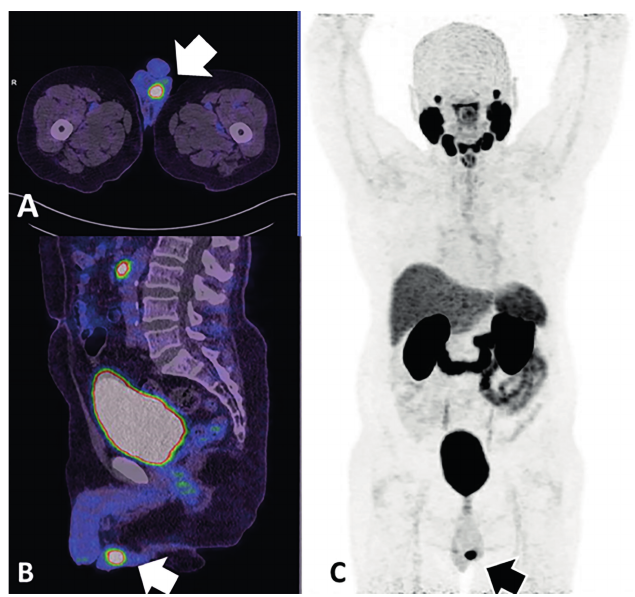
Figure 3 - Testicular metastasis.